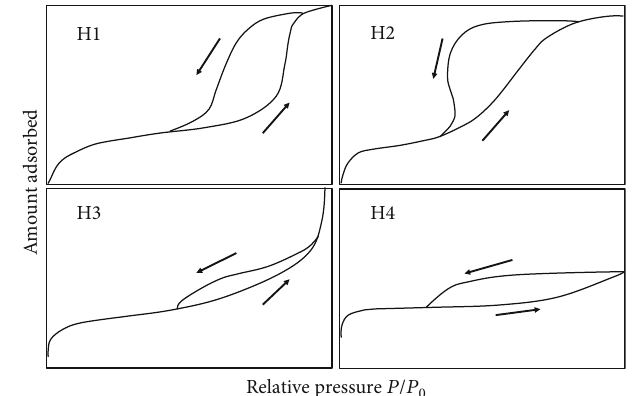
Figure 2: IUPAC classi fi cation of hysteresis loops [47].